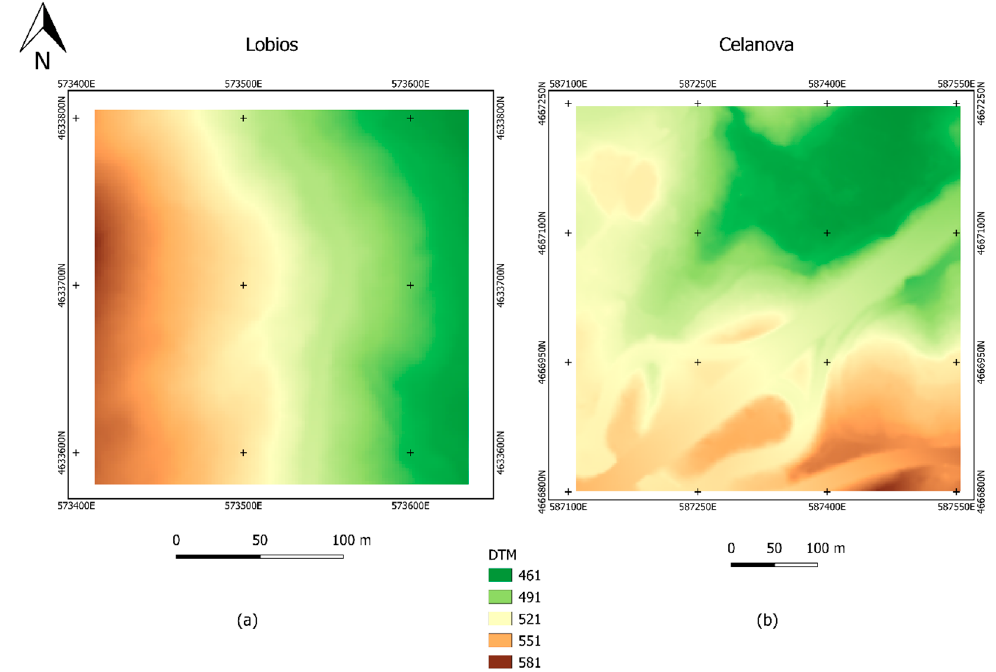
Figure 4. DTM maps. ( a ) DTM map of study area A in Lobios municipality; ( b ) DTM map of study area B in Celanova municipality. Legend indicates height in meters. The map coordinate system is EPSG:25829 ETRS89 / UTM zone 29N.